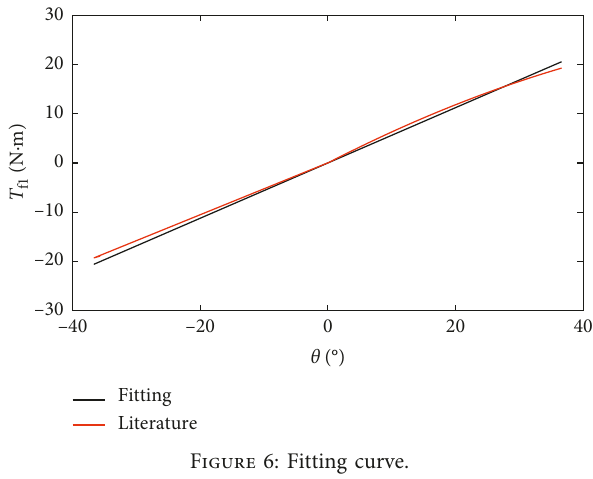
Figure 6: Fitting curve.